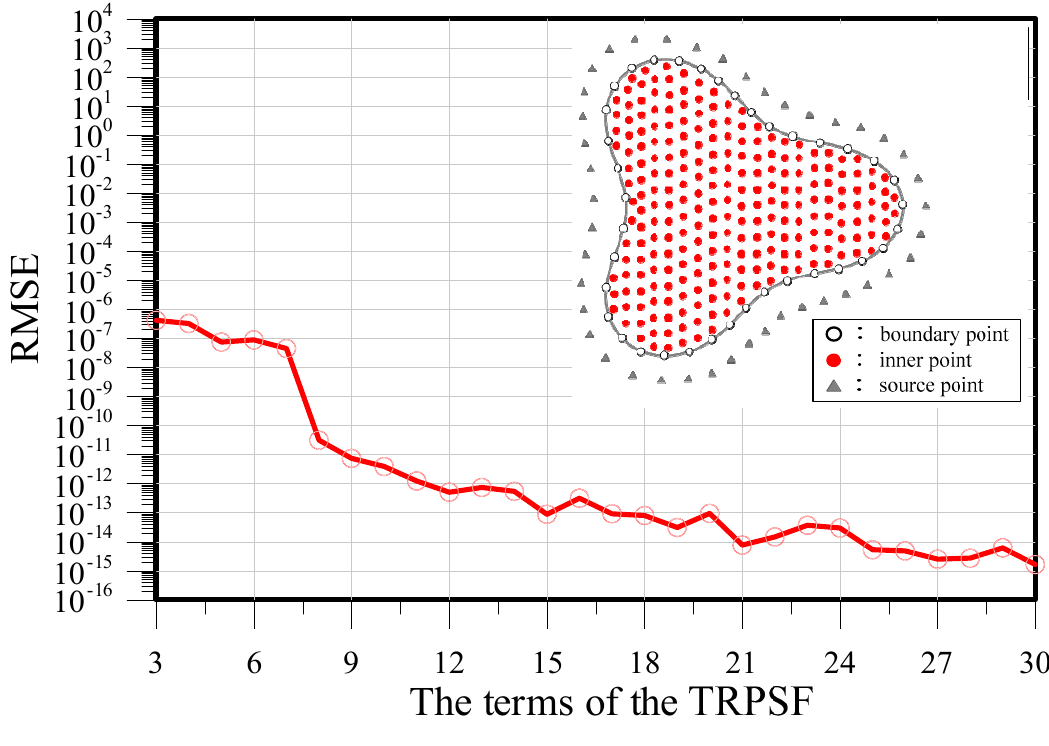
Figure 8. TRPSF terms versus RMSE.